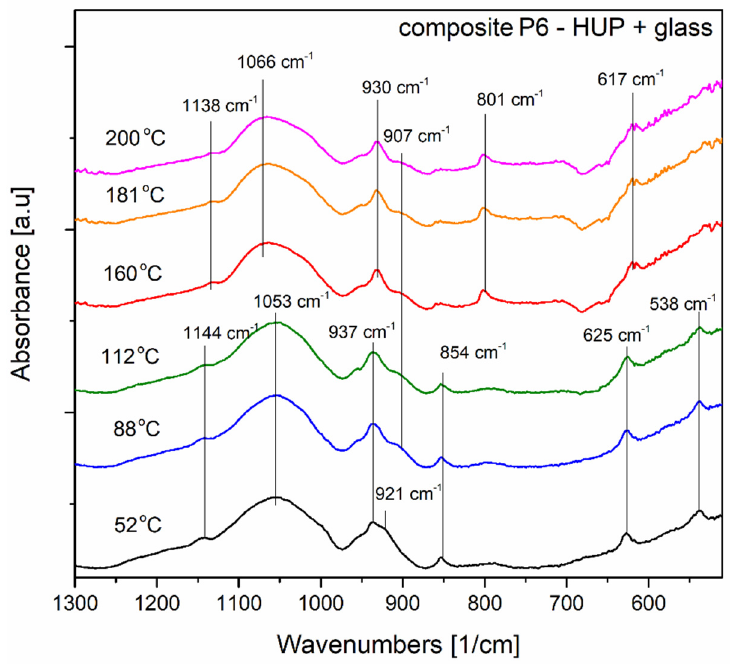
Figure 10. FTIR-ATR spectra of P6 composite samples (40% Gm + 60% HUP) acquired at elevated temperatures. The prominent maxima positions were marked, and the spectra were normed and shifted for clarity.